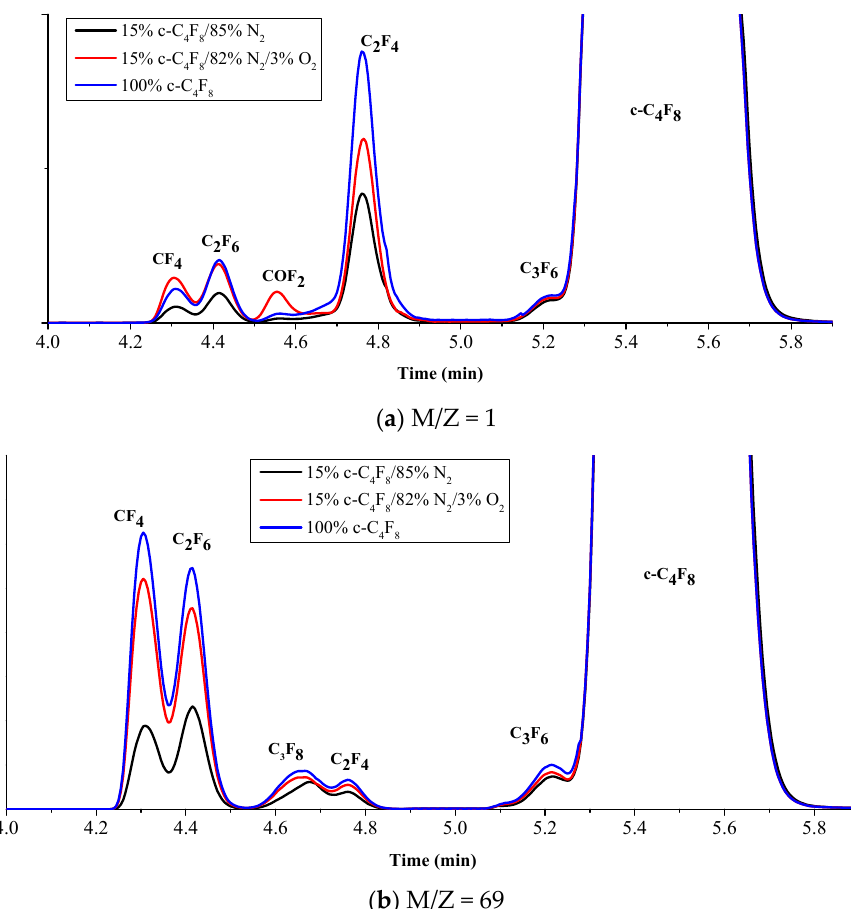
Figure 5. Chromatogram analysis of GC-MS ( The ordinate indicates the relative peak intensity).